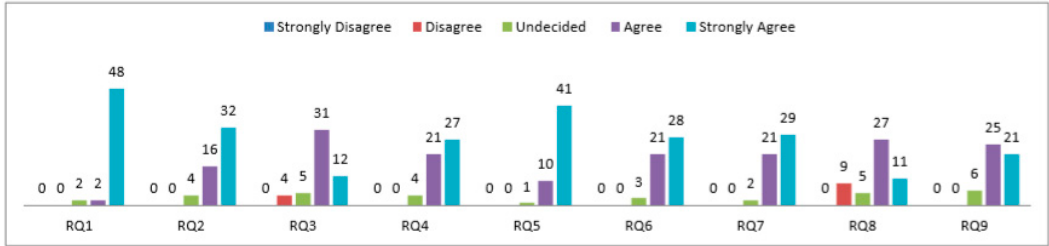
Figure 15. Distribution of the participants’ answers per research question.